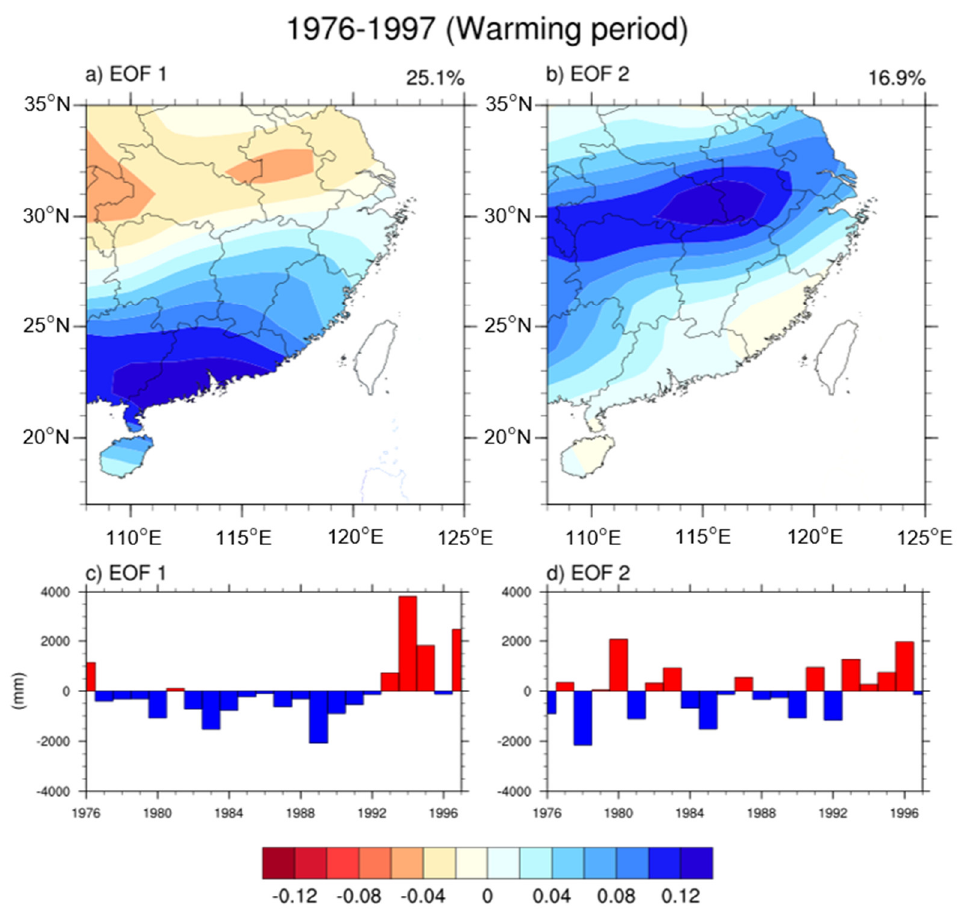
Figure 9. Same as Figure 7, but for the global warming period (1976–1997).